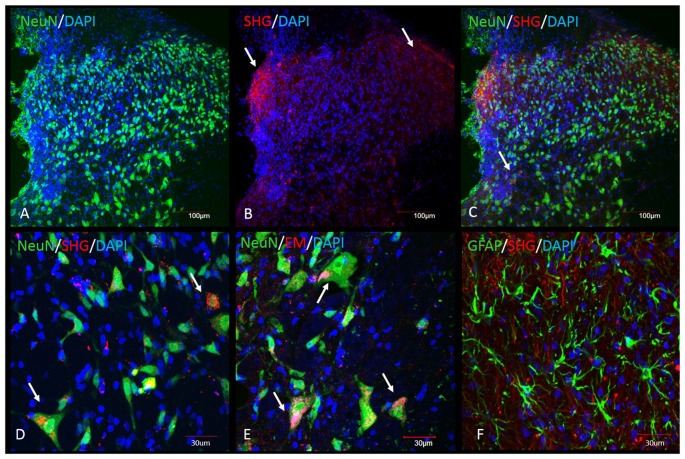
Immunohistochemical detection of recombinant SHG and EM1 peptides in the spinal cord of SCI animals. Both peptides were detected in the vicinity of the injection site with rostral and caudal spread within 1 mm. Top panel: Low magnification of spinal dorsal horn from animals after injection of the recombinant constructs. (A) NeuN and DAPI staining at the level of the injection site. SHG immunostaining was used to visualize the location of the construct. SHG positive fibers were detected in the lateral and medial side of the dorsal horn (arrows in B) and as a punctate cytoplasmic staining in NeuN cells (arrows in C). Bottom panel: Higher magnification of some of the neuronal and glial cells from the dorsal horn. Colocalization of NeuN with SHG (D) and EM1 (E) confirm transduction of neuronal cells (arrows). No significant colocalization with GFAP marker have been found (F).